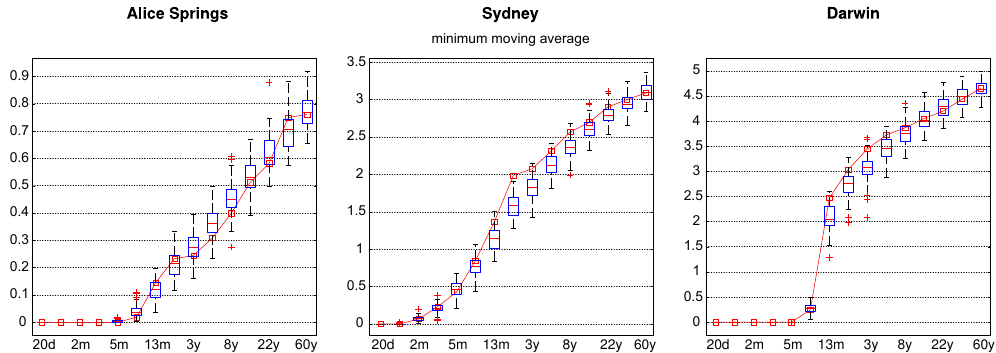
Fig. 7. Minimum moving average of daily rainfall [ mm ] for different running window lengths (days, months or years). The solid line indicates the reference.